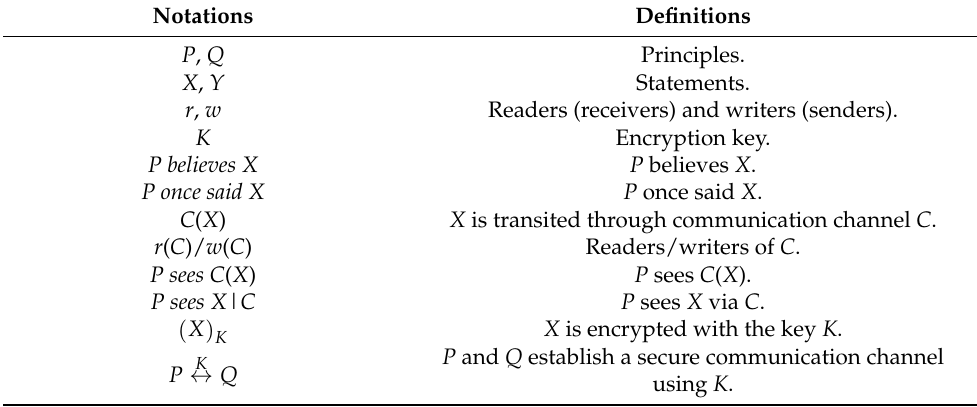
Table 2. Notations of BAN logic [52] used in analyzing the proposed